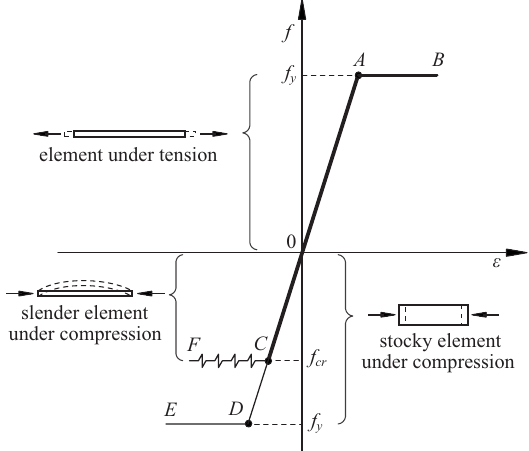
Fig. 1. Stress-strain graph of perfectly elastic-plastic